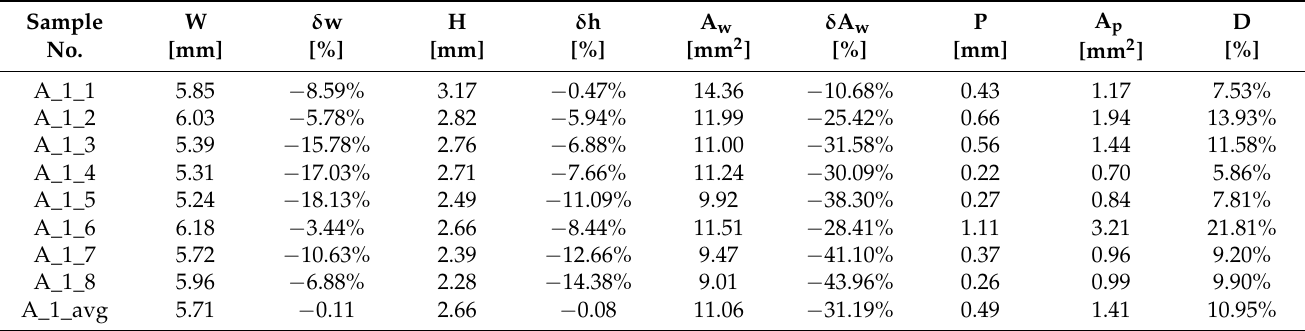
Table A1. Measurements of dimensional features of 1st parameter set of Wire A—wire feed